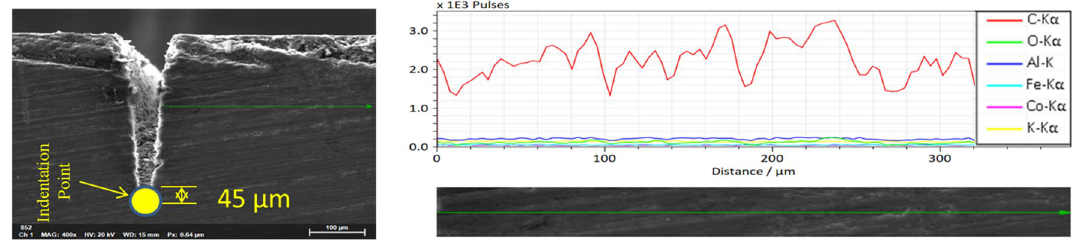
Figure 21. Chemical and hardness tests on cross-section—500 kHz.